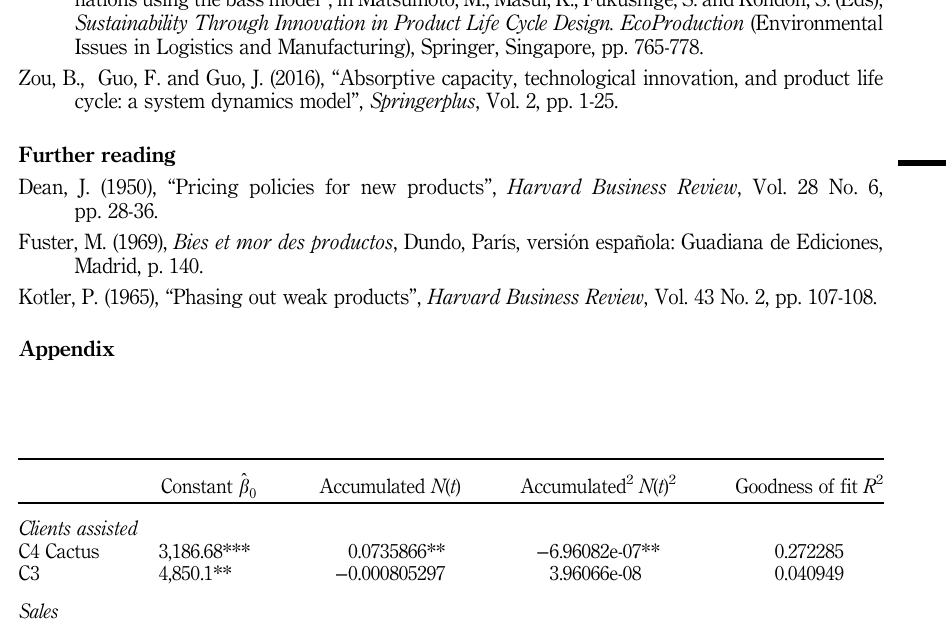
Table AI. MOLS estimation for